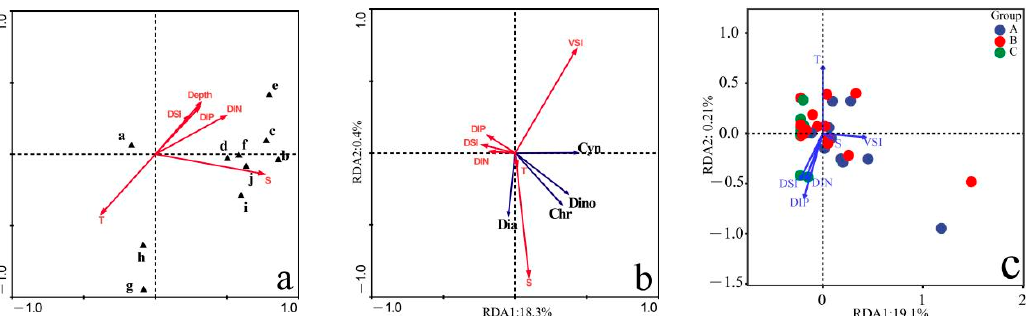
Figure 9. The correlation between species and environmental factors. ( a ) The correlation between the dominant species of phytoplankton and environmental factors. (a) Trichodesmium spp.; (b) Synedra spp.; (c) Prorocentrum lenticulatum; (d) Coscinodiscus granii; (e) Eunotogramma debile; (f) Dictyocha fibula; (g) Thalassionema frauenfeldii; (h) Tripos furca; (i) Planktoniella formosa; (j) Coscinodiscus subtilis . ( b ) Redundancy analysis of the phytoplankton and environmental parameters. ( c ) Groups and environmental parameters in the BOB. (Temperature: T; Salinity: S; Vertical Stratification Index: VSI; Dissolved Inorganic Nitrogen: DIN; Dissolved Inorganic Phosphorus: DIP; Dissolved Silicate: DSI; Diatoms: Dia; Dinoflagellate: Dino; Cyanobacteria: Cyn; Ochrophyta: Chr; Redundancy analysis: RDA).